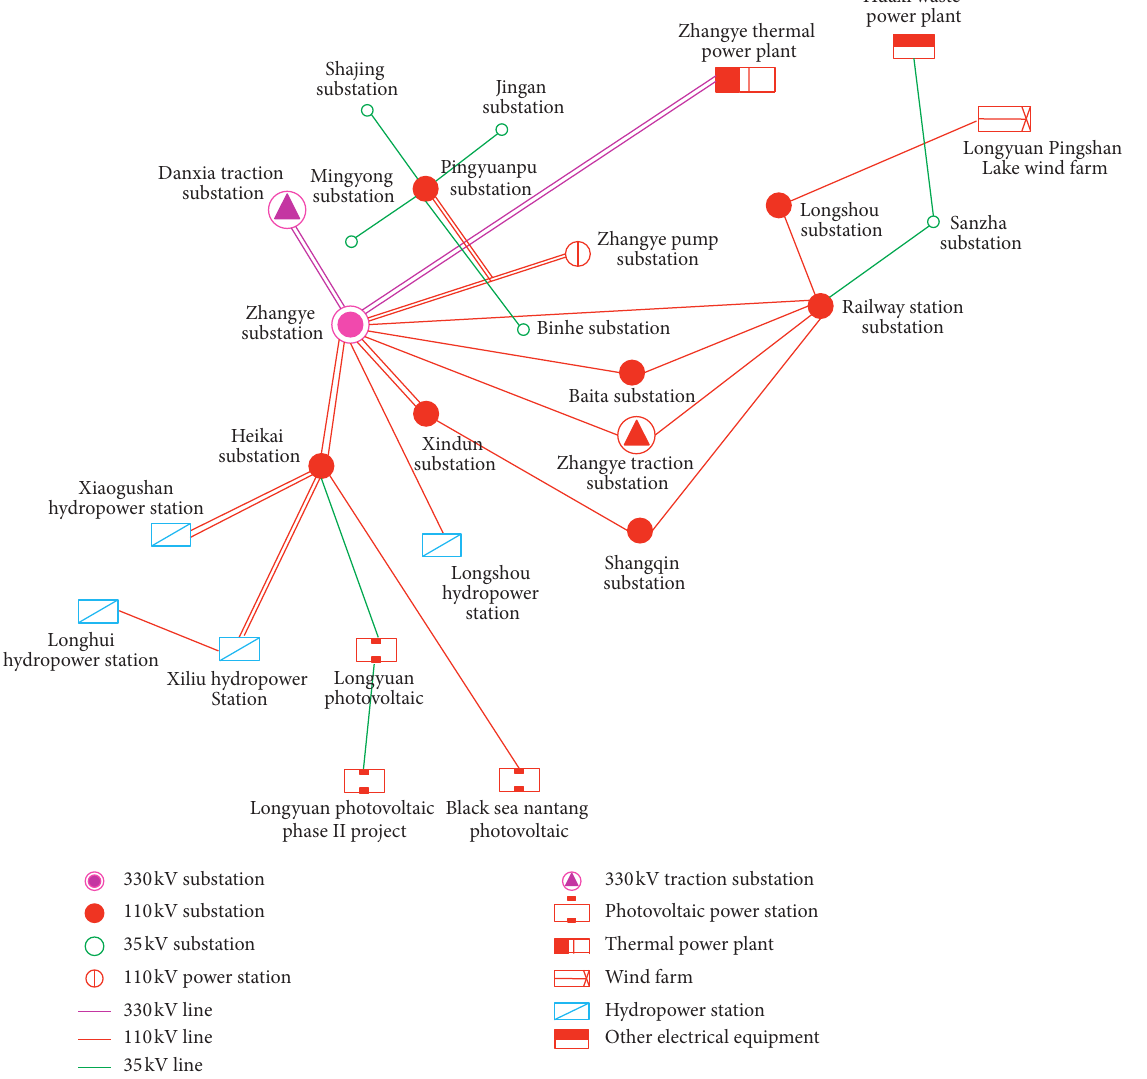
Figure 4: The topological structure of the regional power grid in